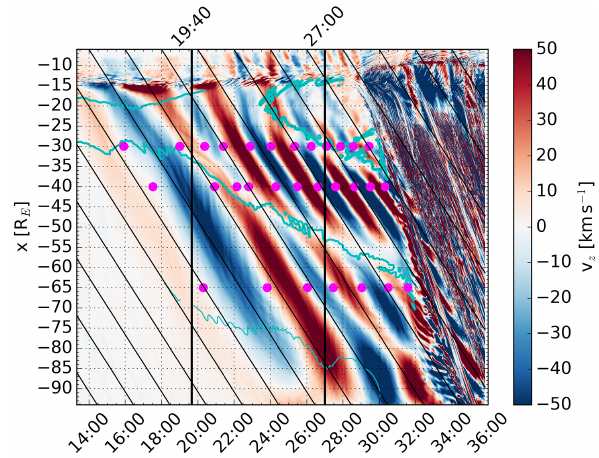
Figure 3. The same as Fig. 2 except that the color shows the time derivative of B x . The color scale has been saturated to better show the relevant structures.